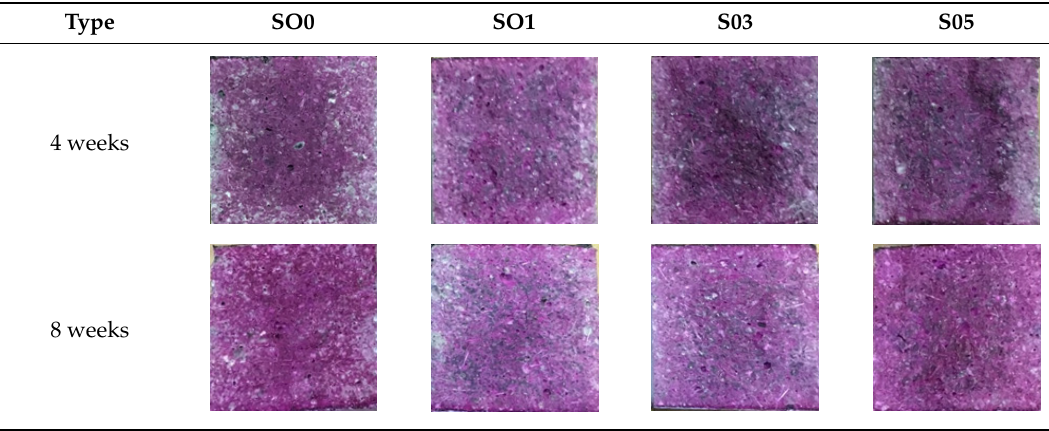
Table 5. Carbonation depth.